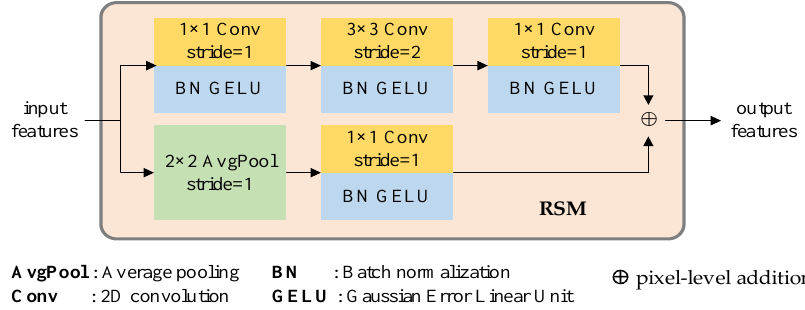
Figure 2. Input data feature extraction diagram using RSM.